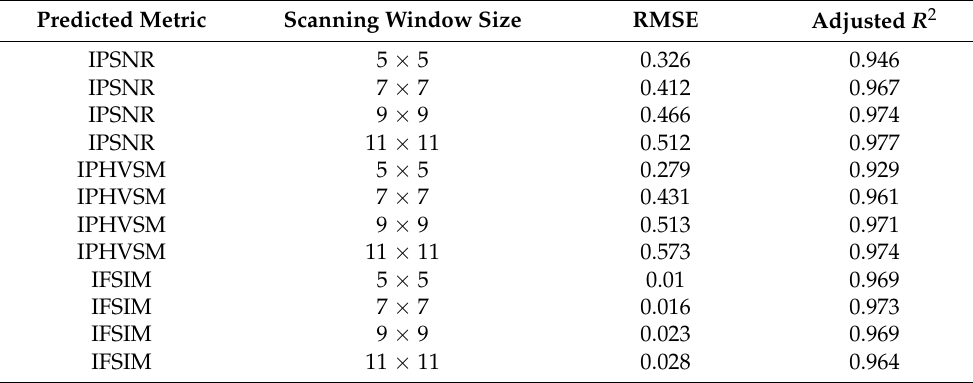
Table 3. Cross-dataset evaluation for Sentinel-2 data, channel #11 with training for Sentinel-2 data, channel